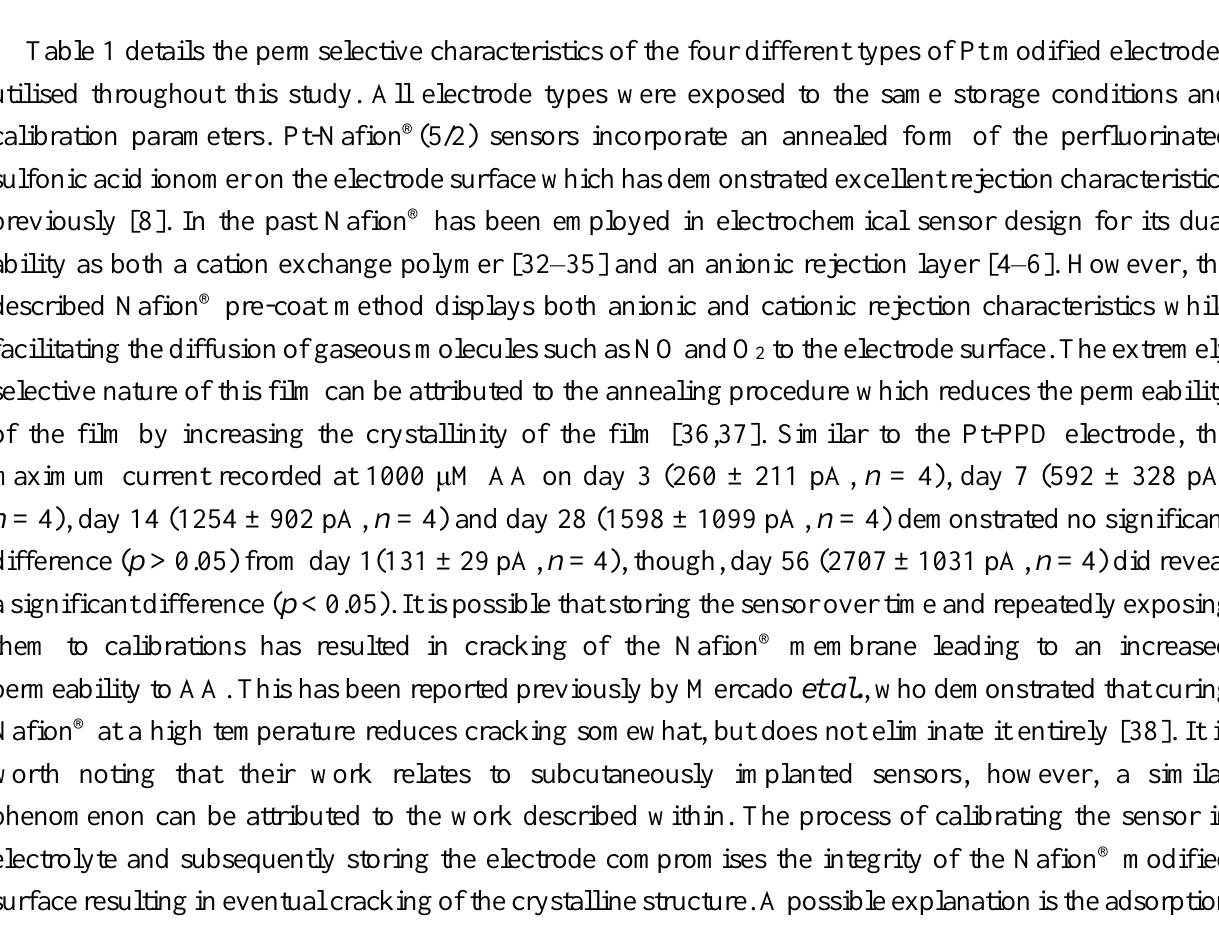
Figure 2. A current-concentration profile for 0–1000 μM AA on Pt-PPD electrodes on day 1 ( n = 4, solid line) vs. day 56 (4 °C storage, n = 4, dashed line) at +900 mV vs. saturated calomel electrode (SCE). Electrodes calibrated on day 1, 3, 7, 14, 28, and 56. (Inset) Typical raw data trace. Arrows indicate injection of AA